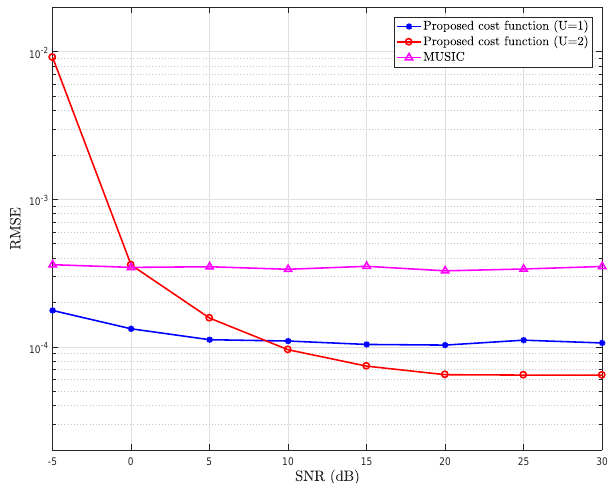
Figure 1. Root mean square error (RMSE) of the mean delay estimation of the proposed cost function for U = 1 ( K − 2 L as noise subspace), U = 2 ( K − 3 L as noise subspace), and multiple signal classification (MUSIC); P l = 20, K = 64, τ lp are uniformly distributed over the interval [ − 0.01,0.01 ] T (standard deviation of the delay spreading is 0.0058 T